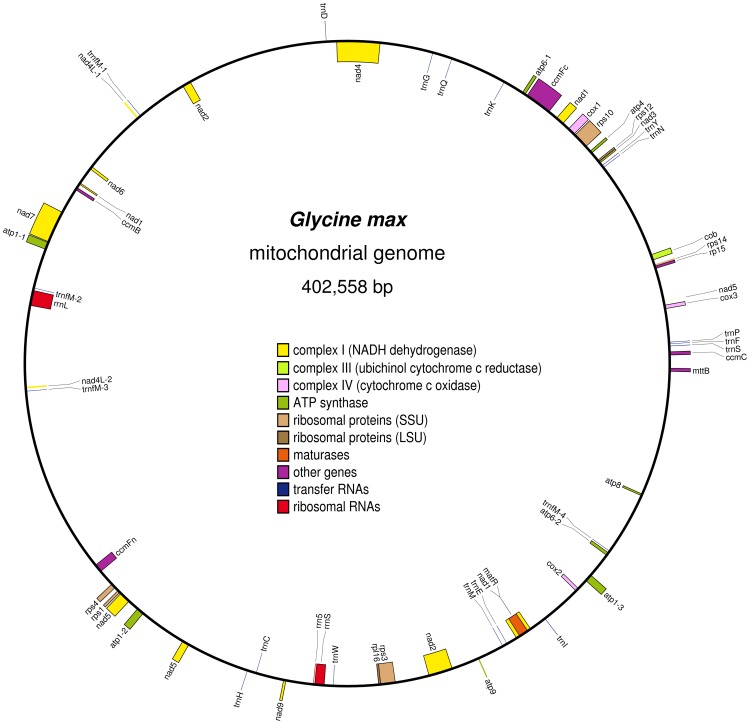
The circular map of the mitochondrial genome of G. max.Features on the clockwise- and counter-clockwise-transcribed strands are drawn on the inside and outside of the circle, respectively. The figure was drawn using OGDraw v1.2 [65].